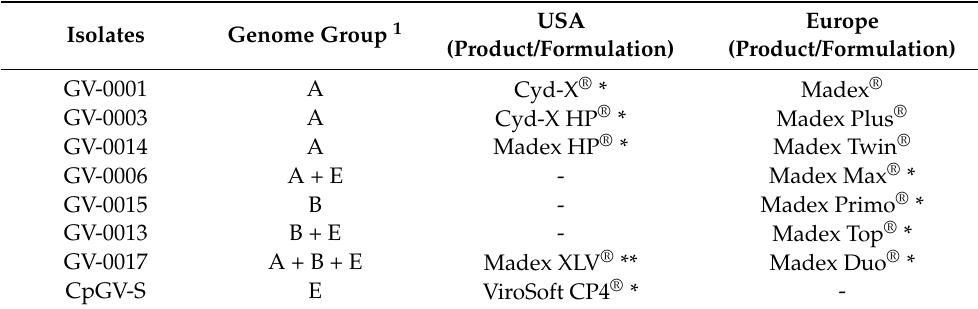
Table 1. Commercial and experimental CpGV products/formulations in the USA and Europe. Preparations used in this study are marked with an asterisk *. USA Europe Isolates Genome Group 1 (Product/Formulation) (Product/Formulation) GV-0001 A Cyd-X ® * Madex ® GV-0003 A Cyd-X HP ® * Madex Plus ® GV-0014 A Madex HP ® * Madex Twin ® GV-0006 A + E - Madex Max ® * GV-0015 B - GV-0013